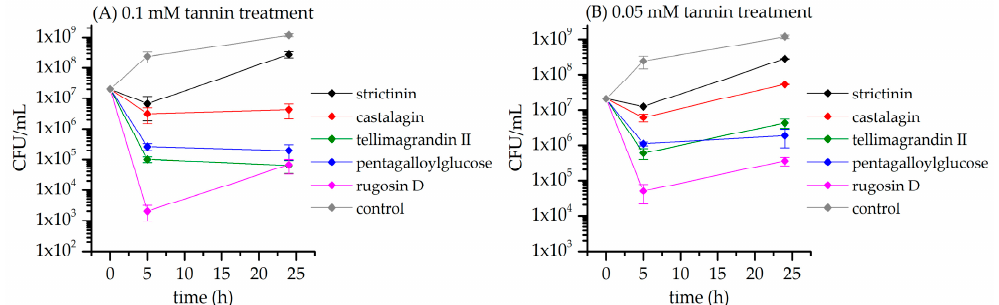
Figure 12. Growth of S. aureus 5 h and 24 h after treatment with ( A ) 0.1 mM and ( B ) 0.05 mM hydrolyzable tannin. Control culture was not treated with hydrolyzable tannins. Bacterial growth is presented as colony-forming units (CFUs) per mL (mean and standard error, n = 3). Similar plating experiments were also performed for the fecal BC set samples, but